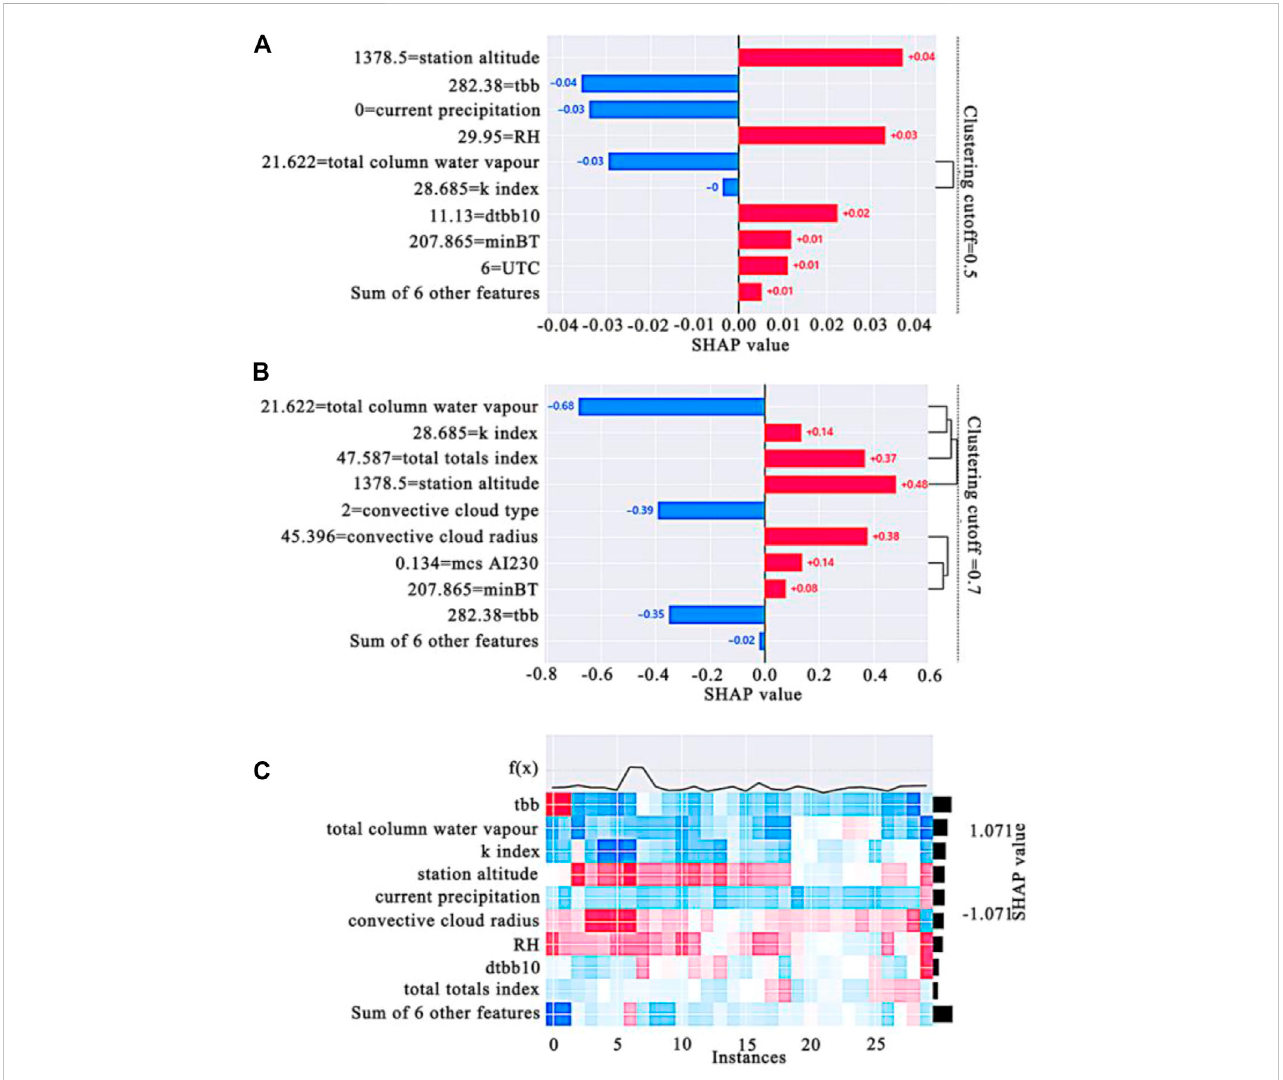
FIGURE 5 Feature clustering: (A) cluster distance < .5; (B) cluster distance < .7; and (C) sample cluster